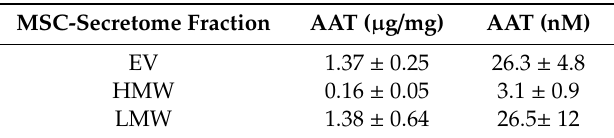
Figure 3. Total proteins and lipids dosed into MSC-secretome fractions. Mean values ± standard deviation, n = 3. Di ff erent letters (a, b, c) indicate significant di ff erences between the means ( p < 0.05), whereas the same letter indicates no significant di ff erence ( p > 0.05). Table 2. AAT content of freeze-dried secretome fractions. Results are expressed as µ g of protein per mg of the freeze-dried sample and mathematically converted to nM, based on a molecular weight of 52 kDa; mean values ± standard deviation, n =